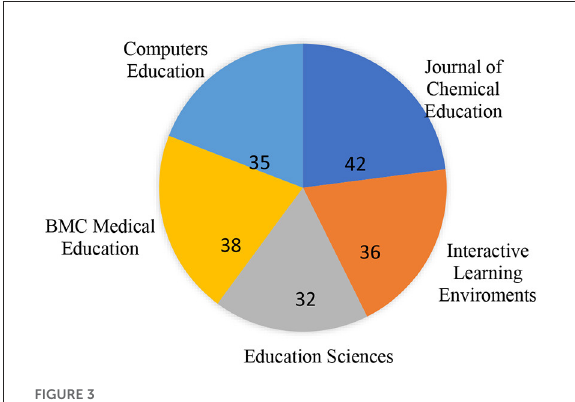
FIGURE3 Main journals in which the greatest number of flipped classroom publications were found. Source: Created by authors from Web of